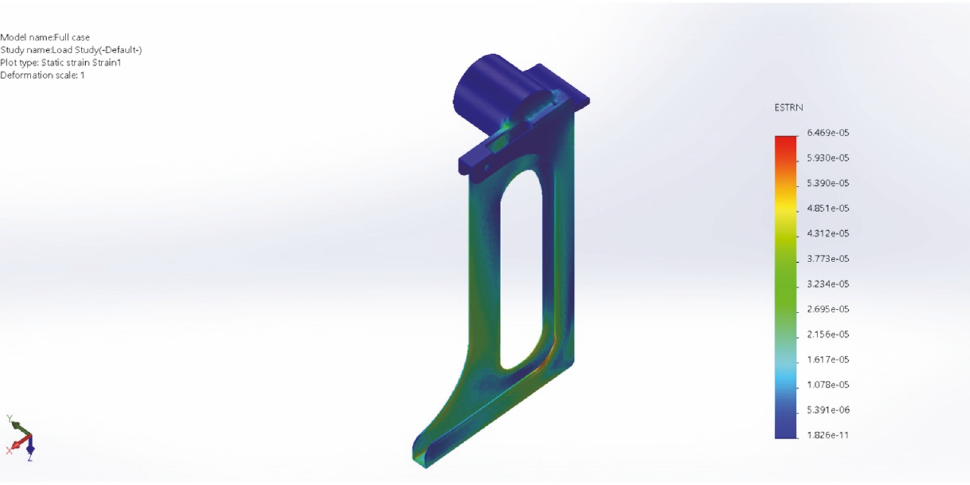
Figure 7: Static strain plot (as the stress is equally distributed we can see no built up strain across the